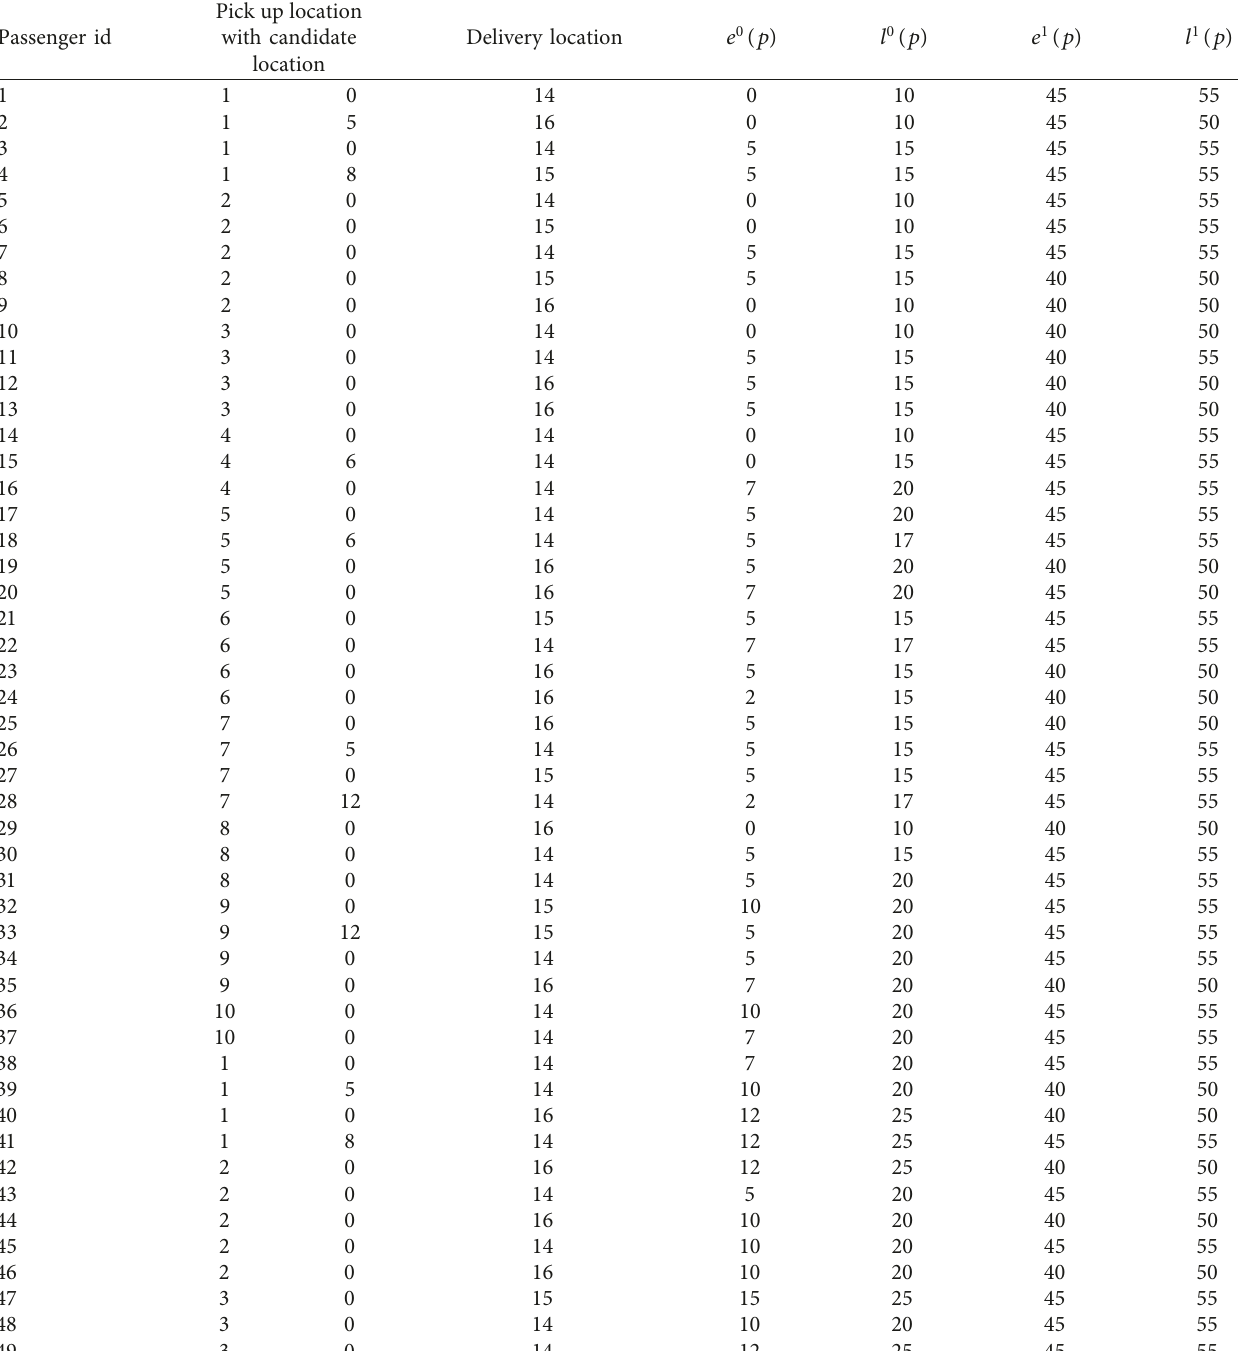
Table 16: Passenger demands information of Group